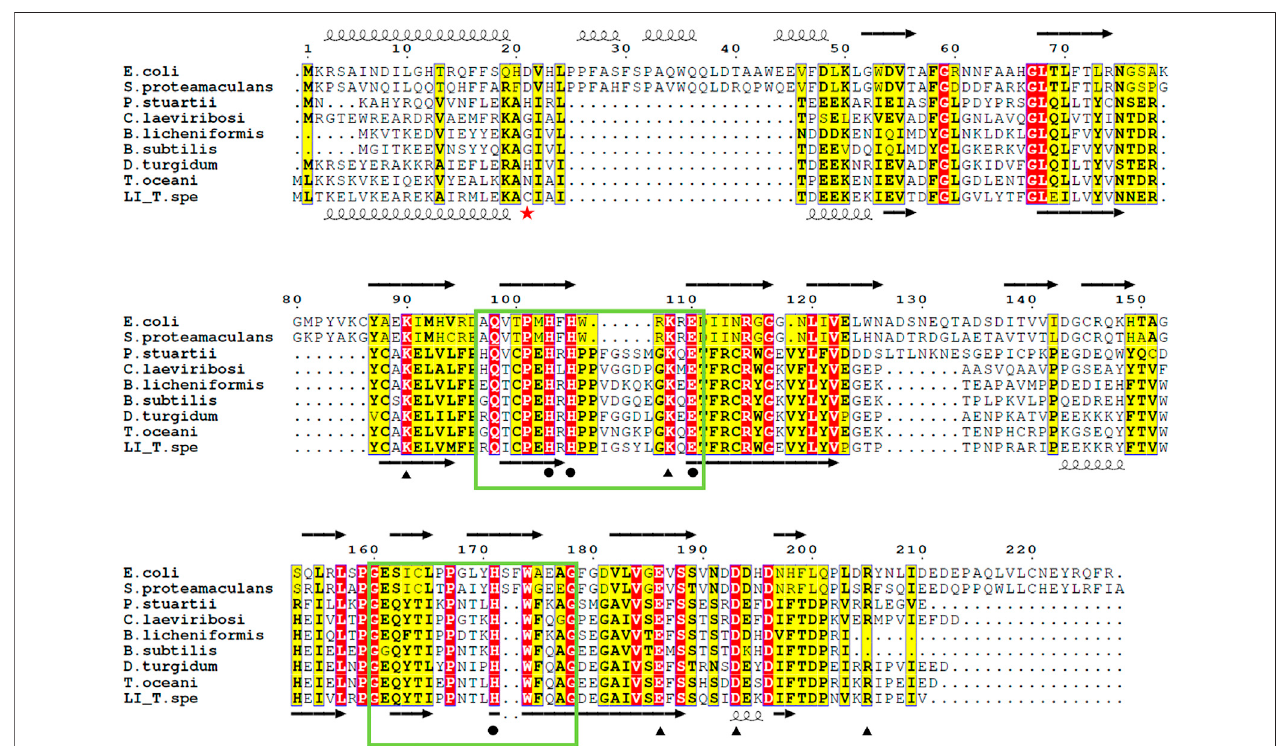
FIGURE 6 | Alignment of the amino acid sequences of various LIs. Residues related to substrate binding sites (black circle), and those involved in both the metal coordination and substrate binding sites (black triangle), according to the ligand bound structures of E. coli LI bound to D-fructose (PDB 3KMH) and B. subtilis LI (PDB 2Y0O).Identicalresiduesareinredwhilesimilarresiduesareinyellow,thegreenboxhighlightsthecupinfamilymotif1and2.Theredstarindicatesthecysteine22which isresponsibleofthedisul fi debondconnectingthedimeroftheTsLI.ThesecondarystructureoftheD-LIfrom E.coli andTsLIarerepresentedatthetopandbottom of the alignment respectively with spring and arrow indicating α helices and β sheets. The alignment was carried out using ESPript 3.0 (http://espript.ibcp.fr/ESPript/ ESPript/) (Robert and Gouet,